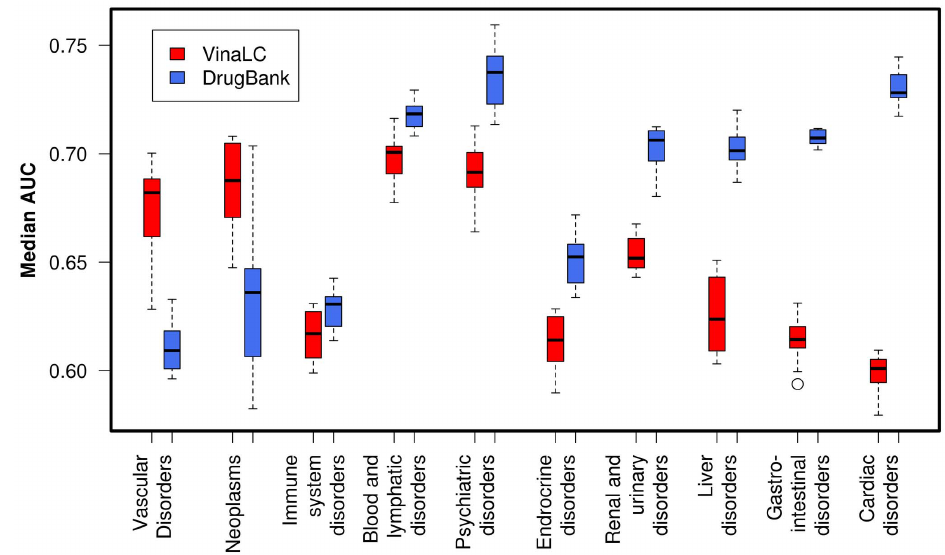
Figure 2. ADR prediction models using ‘Vina Off Targets’ and ‘DrugBank On-Targets’. Boxplots of median AUC results for one vs. all L1- regularized logistic regression models trained using 10-fold cross-validation repeated ten times are shown. The individual models were trained on ten different adverse drug reaction (ADR) groups: Vascular disorders ("Vascular disorders"), Neoplasms, benign, malignant, and unspecified ("Neoplasms"), Immune system disorders ("Immune system disorders"), Blood and lymphatic systems disorders ("Blood and lymphatic disorders"), Psychiatric disorders ("Psychiatric disorders"), Endocrine disorders ("Endocrine disorders"), Renal disorders ("Renal & urinary disorders"), Hepatobiliary disorders ("Liver disorders"), Gastrointestinal disorders ("Gastrointestinal disorders"), and Cardiac disorders ("Cardiac disorders"). Red boxes indicate models trained on 560 6 409 VinaLC docking scores used as drug-protein binding features. Blue boxes indicate models trained on a 560 6 555 matrix containing DrugBank drug-target protein associations. VinaLC off-target models had higher AUCs than DrugBank on-target models for the ‘‘Vascular disorders’’ and ‘‘Neoplasms’’ ADR groups. indicate that the quality of the models are only marginally poorer than those derived from the larger predictor set, but use a factor of , 26 fewer protein features, indicating they may have some value in the drug development pipeline.